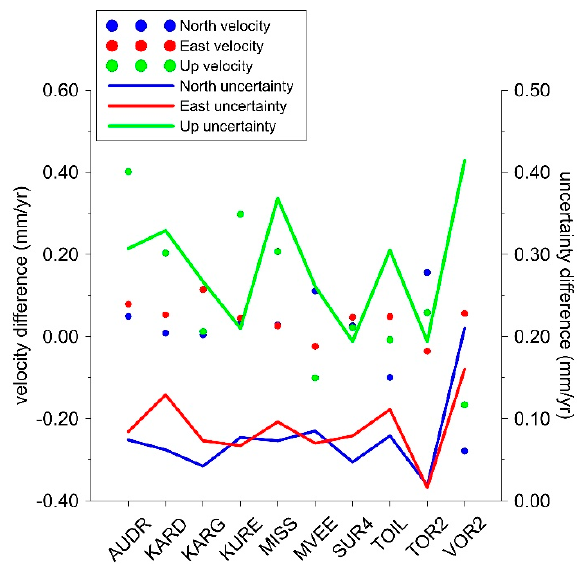
Figure 13. Differences between velocities and their uncertainties of the BERN_2 solution (using FN + WN model for N and E, and GGM model for U) and BERN time-series’ MIDAS solution.